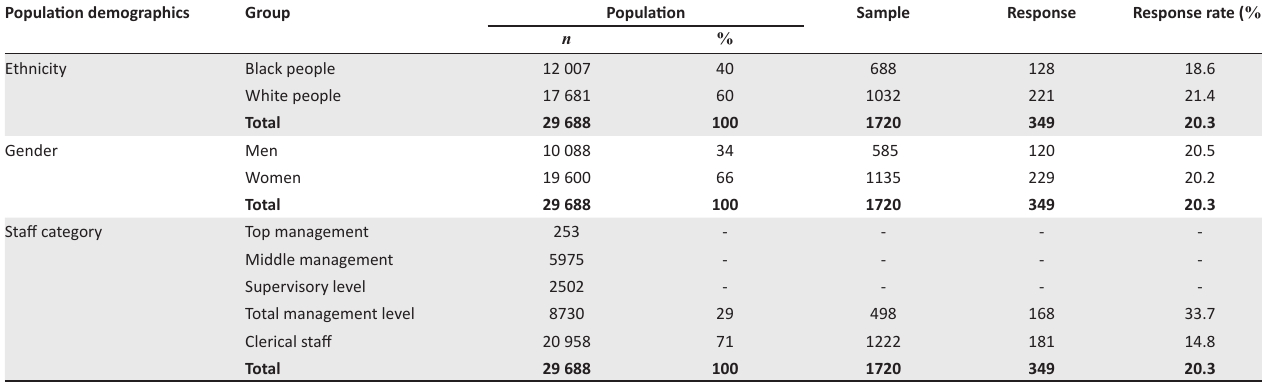
TABLE 1: Population, sample and resonse rate of each group. Population demographics